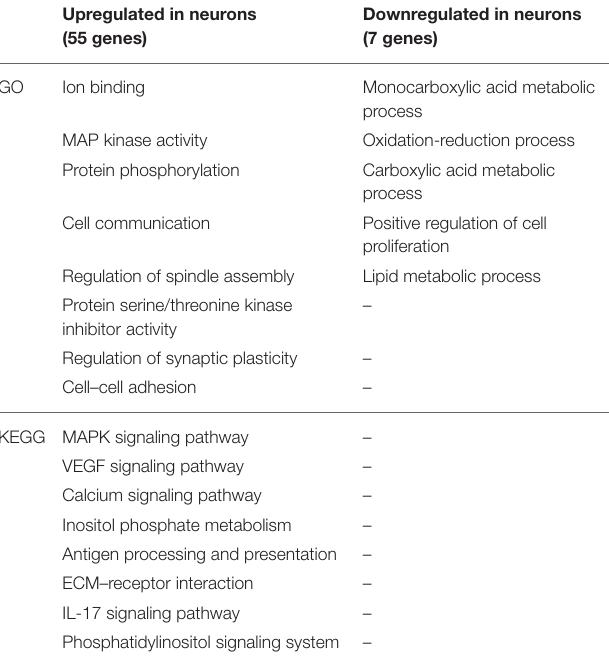
TABLE 7 | Selection of relevant Gene Ontology (GO) and Kyoto Encyclopedia of Genes and Genomes (KEGG) terms of the differentially expressed genes in neurons in the ipsilateral hippocampus (but not in the contralateral hippocampus) at 24h after kainate-induced status epilepticus. Upregulated in neurons (55 genes)